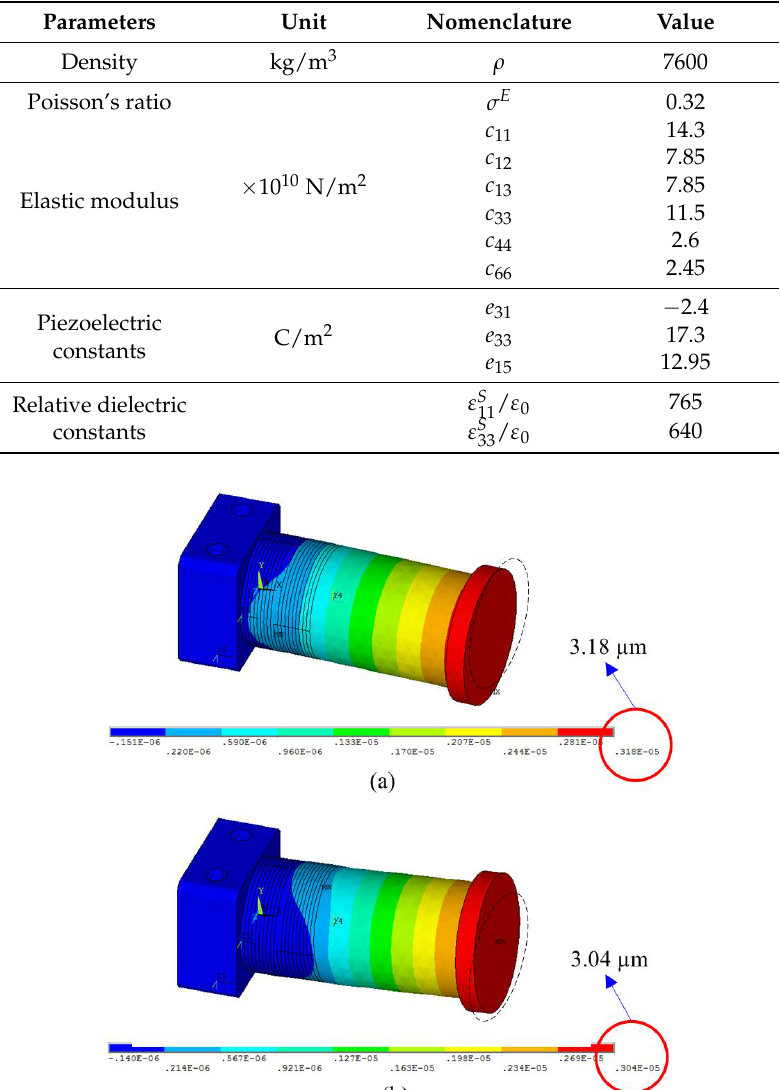
Table 1. The parameters of the PZT elements.